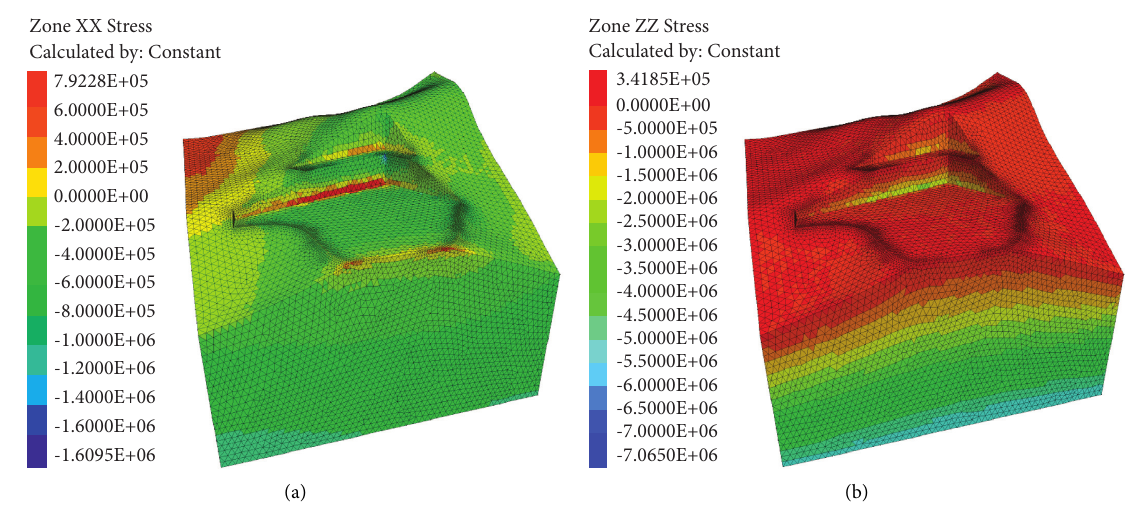
Figure 13: Stress nephogram after forth excavation. (a) X -direction stress nephogram and (b) Z -direction stress